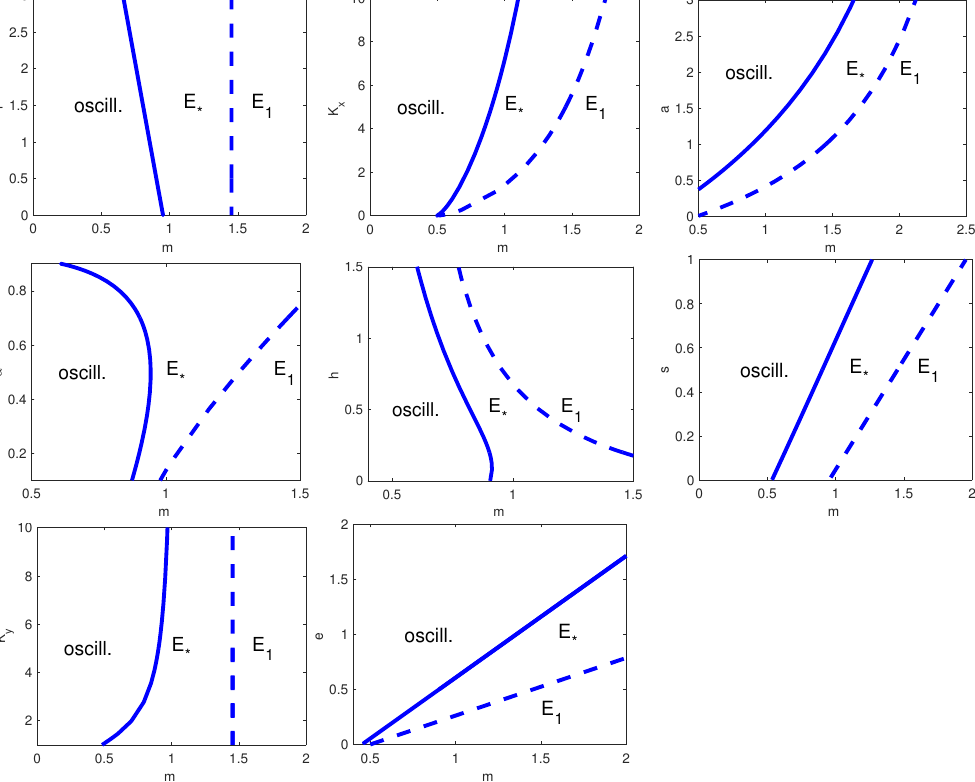
Figure 8. Two-parameters bifurcation diagram with respect to m and, from top left to bottom right, r , K x , a , α , h , s , K y , and e . Thick line: HB curve; dashed line: transcritical bifurcation curve. E ∗ is the coexistence equilibrium and E 1 the prey-only equilibrium. The remaining parameter values are as in Table